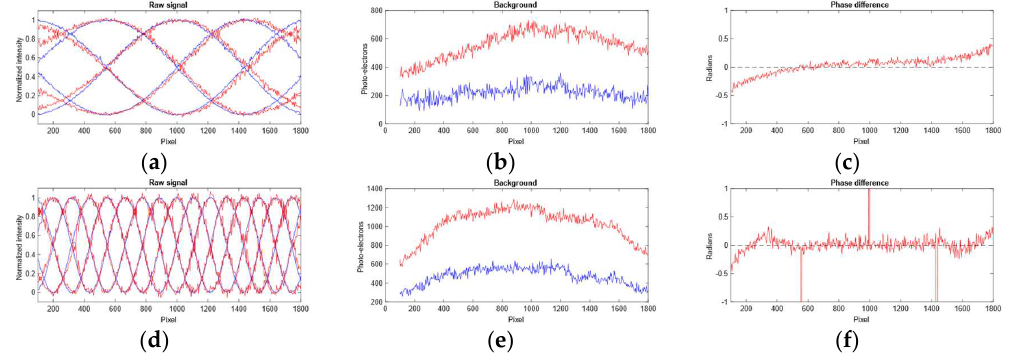
Figure 8. Effect of turbidity on phase estimates. The intensity and phase profiles are taken along row 200 of the images in Figure 7. Blue curves denote data from turbidity level λ 0 = 5.9 m while red curve denotes data from turbidity level λ 2 = 1.1 m. The upper and lower rows contain results for a sinusoid pattern with one and four frequency data respectively. ( a , d ) Normalized intensity plots. ( b , e ) Estimated background levels according to I b . ( c , f ) Phase difference between the phase estimated at λ 0 and λ 2 . The outliers in ( f ) occur at the phase wrapping boundary.